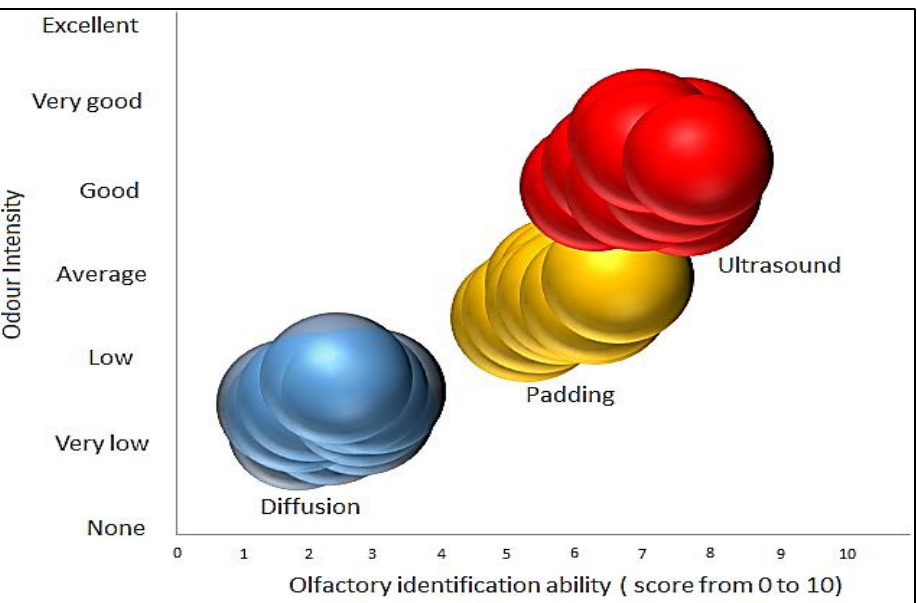
Figure 7. Comparison of olfactory stimulation effects on the treatment